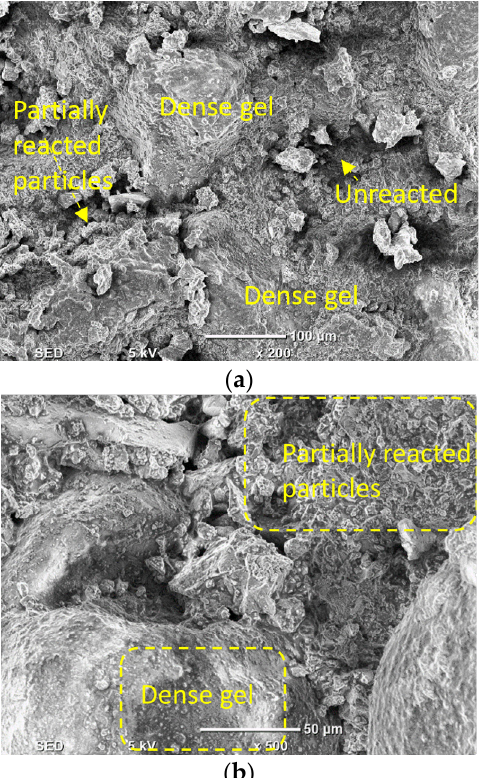
Figure 17. SEM micrograph of alkali-activated samples with both DCP and RM ( a ) MC7.5RM7.5; ( b ) MC30RM30.